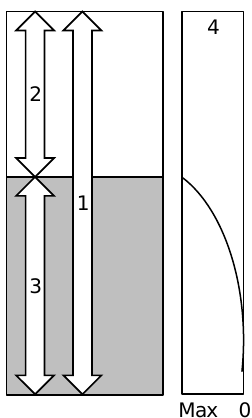
Fig. 3. Generic bucket structure (left) and relative evapotranspira- tion rate as a function of water depth (right). The maximum depth of water in a bucket (1; Table 1 b 1 ) can be partitioned into freely draining water (2) and water that may contribute to evapotranspira- tion but not drainage (3; b 2 ) . The rate of evapotranspiration (4) is not constrained when there is freely draining water in the bucket. When the water depth drops below the freely draining depth, evap- otranspiration is limited as a power function of water